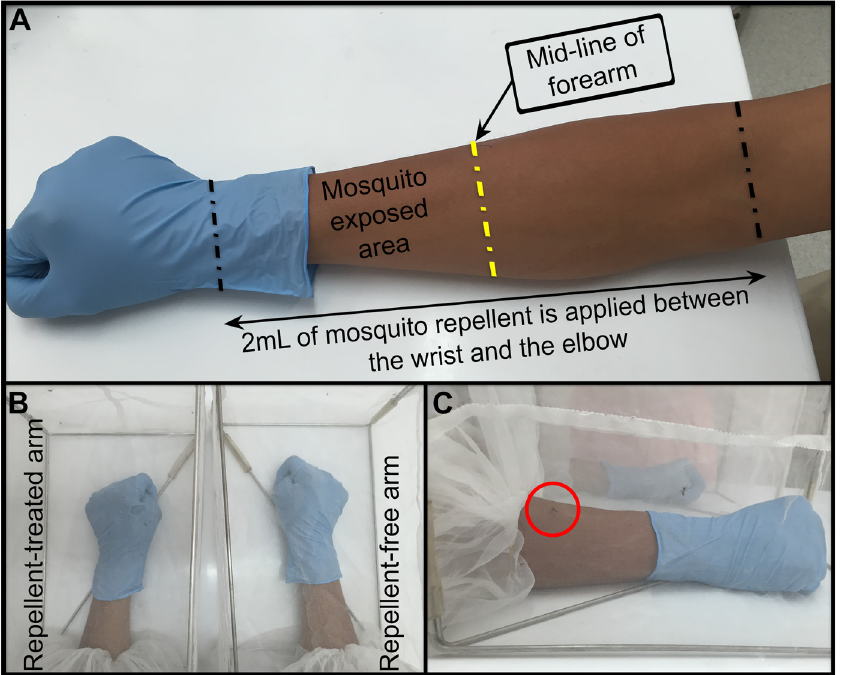
Fig 1. Annotated photos of the “ arm-in-cage ” method. (A) Mosquito repellent (2 mL) was applied onto all sides of a single forearm, between the elbow and wrist (repellent-treated arm). The opposite limb had no repellent applied, and was used as an internal control (repellent free arm). (B) The participant inserted her/his arms into the two mosquito cages simultaneously. Each cage contained ten Aedes aegypti mosquitoes. (C) A mosquito (circled) landing on a participant ’ s arm during an exposure. The arms were exposed for a maximum of 2 minutes each time. “ Landing for 2 seconds ” was used as a proxy for mosquito biting. After a mosquito landed on a participant, they were asked to shake off the mosquito and withdraw their arm from the cage. Alternatively, the participant withdrew their arms only at the end of the two-minute exposure if there was no mosquito landing, and the exposure was repeated at the next scheduled